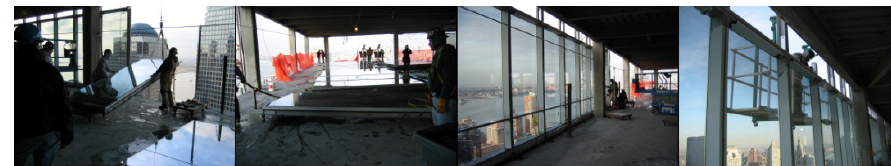
Figure 16: the design of the curtain wall allowed for ease of installation. The units are laid out on dollies; an exterior crane lifts each unit out where it is rotated and secured to the